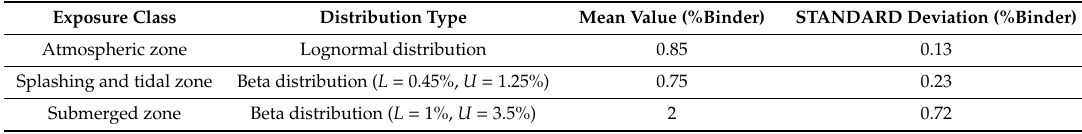
Table 3. The probability distribution of chloride threshold concentration C cr